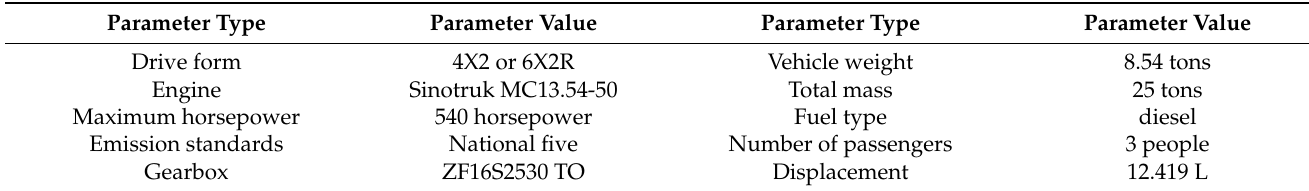
Table 2. Parameters of Shandeka SITRAK HDDTs.